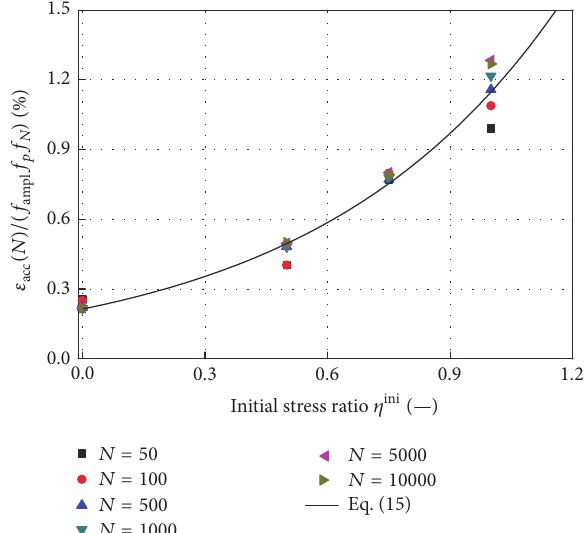
Figure 12: Normalized accumulated axial strain versus cyclic stress amplitude.